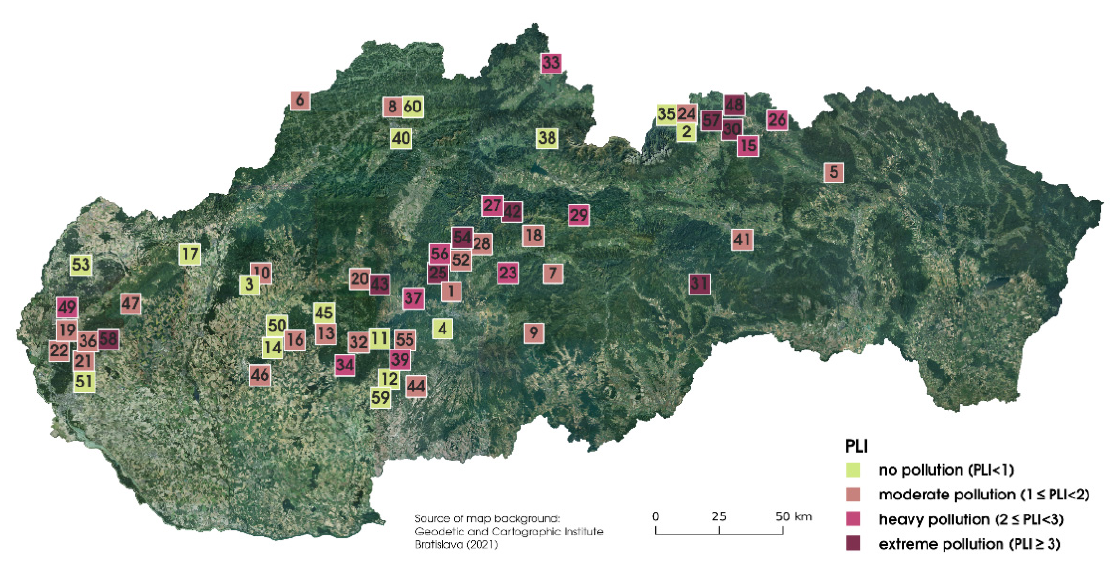
Figure 3. Pollution load index (PLI) values determined for individual sampling localities.